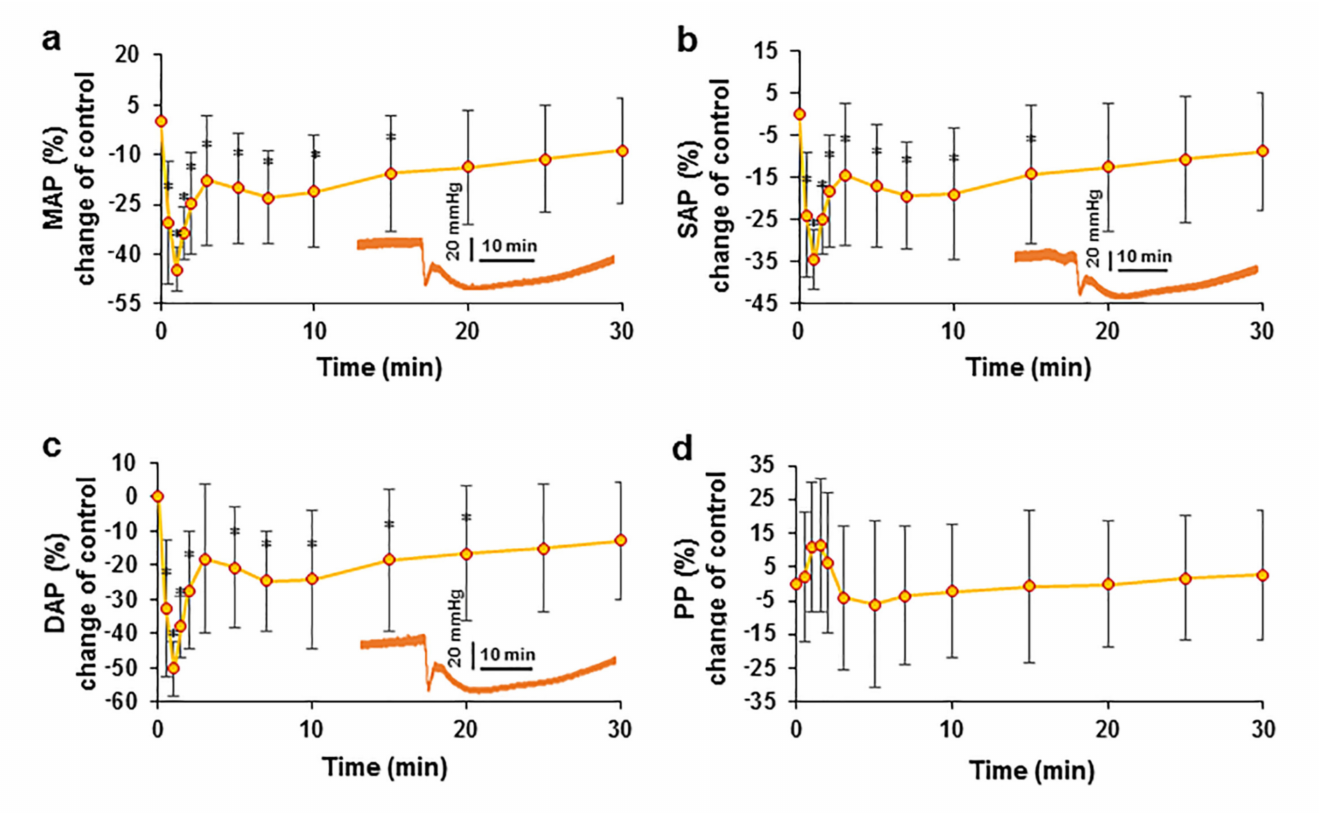
Figure 2. Effect of an intravenous injection of an EO bolus on arterial blood pressure in pigs. The changes in MAP ( a ), SAP ( b ), DAP ( c ), and PP ( d ) after intravenous bolus administration are presented as percent changes compared with the control. * p < 0.05 indicates a significant difference from controls, n =